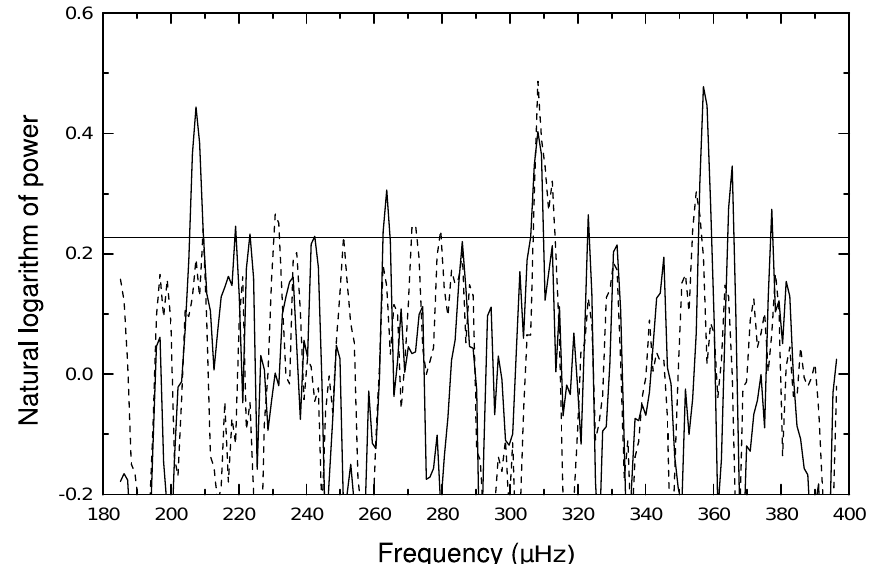
Fig. 3. Product spectra of ground pressure (continuous line) and seismic (dashed line) oscillations in the 42 − 90-min period subrange, obtained from winter measurements by microbarograph and seismograph at St.Petersburg (60 ◦ N, 30 ◦ E). The horizontal line represents 10% probability